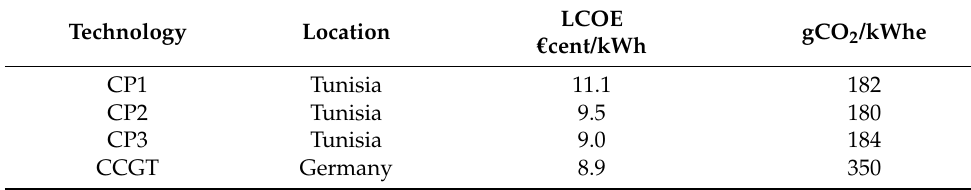
Table 9. Comparison between the LCOE and the CO 2